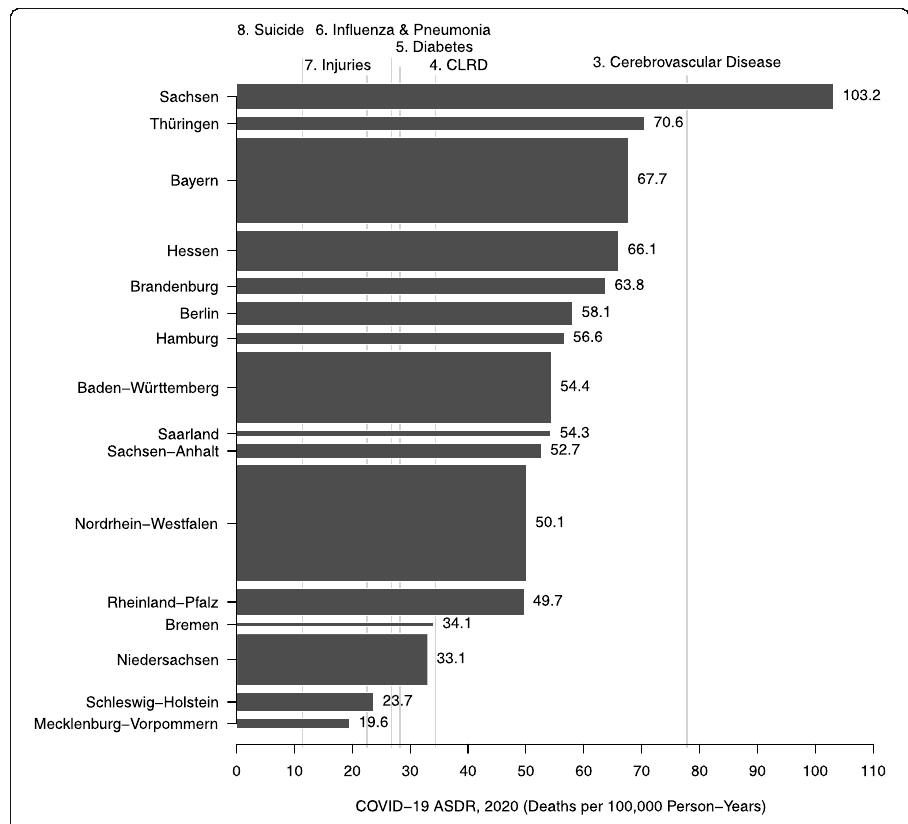
Fig. 5 Age-standardized death rate from COVID-19 in Germany. Source: authors ’ calculations. Note: the height of each rectangle is proportional to the population size of each